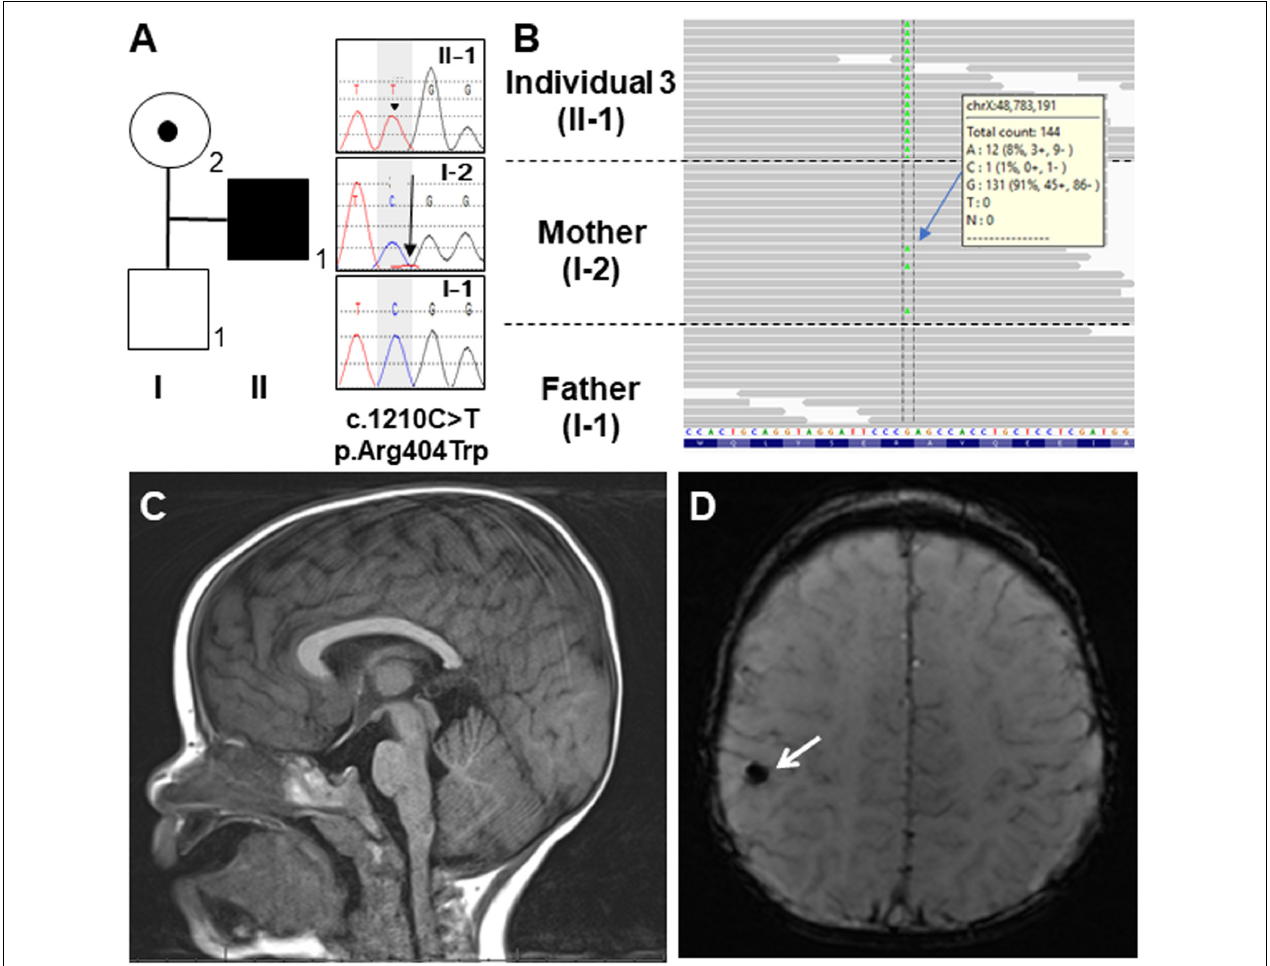
FIGURE 2 | (A) Familial pedigree of Individual 3 and DNA sequence electropherograms illustrating the OTUD5 variant (c.1210C > T, p.Asn404Trp [NM_017602.4]). Arrow head of the proband (II-1) in the electropherogram shows the mutated allele (C > T) in a hemizygous state. The arrow in the mother’s electropherogram (I-2) indicates the mutated allele in a mosaic state. (B) Integrated genomic view demonstrating that the variant can be seen in the hemizygous state in Individual 3 and in some of the reads from his mosaic mother. (C) Sagittal view of the brain MRI of Individual 3 at 19 months of age. His corpus callosum was normal. (D) Coronal view. The white arrow showed a hypointense focus in the right perirolandic region, which most likely represents hemosiderin deposition secondary to a previous